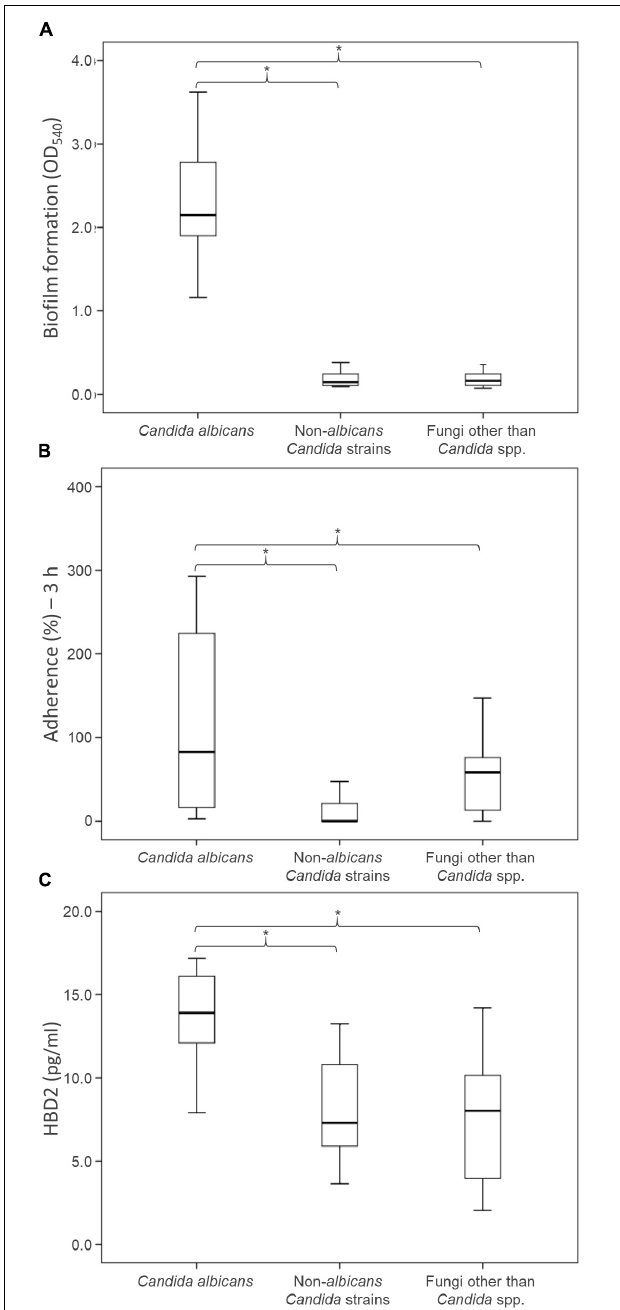
FIGURE 3 | Health relevant properties of the fungi isolated from fecal specimens of healthy donors: biofilm production (A) , adhesion to epithelial Caco-2 cells (B) , and induction of HBD-2 production in CaCo-2 cells (C) . Boxes indicate the median and 25th and 75th percentiles; whiskers indicate 10th and 90th percentiles; ∗ indicate groups with significantly different means ( P < 0.05).